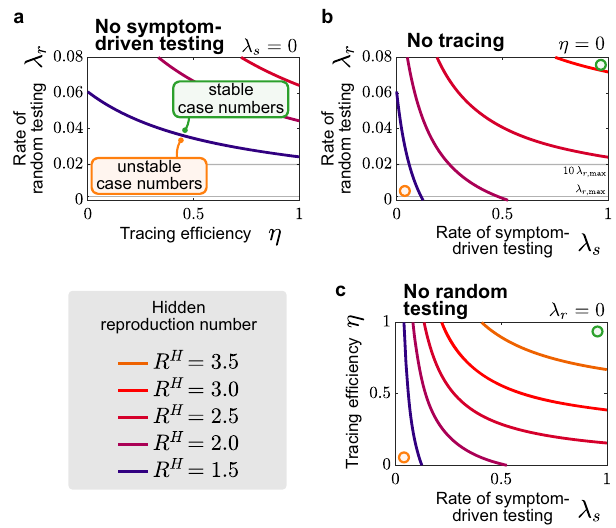
Fig. 7 Symptom-driven testing and contact tracing need to be combined to control the disease. Stability diagrams showing the boundaries (continuous curves) between the stable (controlled) and uncontrolled regimes for different testing strategies combining random testing (rate λ r ), symptom-driven testing (rate λ s ), and tracing (ef fi ciency η ). Gray lines in plots with λ r -axes indicate capacity limits (for our example Germany) on random testing ( λ r ; max ) and when using pooling of ten samples, i.e., 10 λ r ; max . Colored lines depict the transitions between the stable and the unstable regime for a given reproduction number R H t (color-coded). The transition from ‘ stable" to ‘ unstable" case numbers is explicitly annotated for R H t ¼ 1 : 5 in panel a . a Combining tracing and random testing without symptom- driven testing is in all cases not suf fi cient to control outbreaks, as the necessary random tests exceed even the pooled testing capacity (10 λ r ; max ). contract tracing requires unrealistically high levels of random testing to ( R H t > 2 : 0). The required random tests to signi fi cantly change the stability boundaries exceed the available capacity in Germany λ r ; max . Even considering the possibility of pooling tests (10 λ r ; max ) often does not suf fi ce to control outbreaks. c Combining symptom-driven testing and tracing suf fi ces to control outbreaks with realistic testing rates λ s and tracing ef fi ciencies η for moderate values of reproduction numbers in the hidden pool, R H t , but fails to control the outbreak for large R H t . The curves showing the critical reproduction number are obtained from the linear stability analysis (Supplementary Eq.